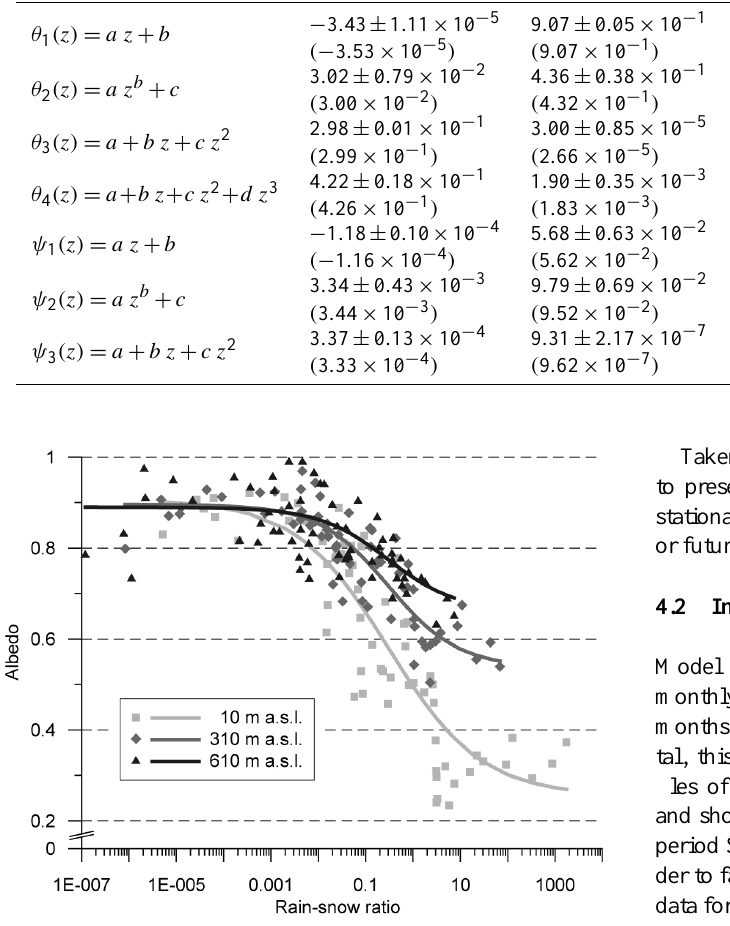
Fig. 2. Rain-snow ratio versus MODIS-derived surface albedo for three selected 20m elevation bins. Bins are centred at the elevations given in the legend. Given data pairs refer to the period March– October of the years 2001–2008. Lines represent the fitted sigmoid functions according to Eq.